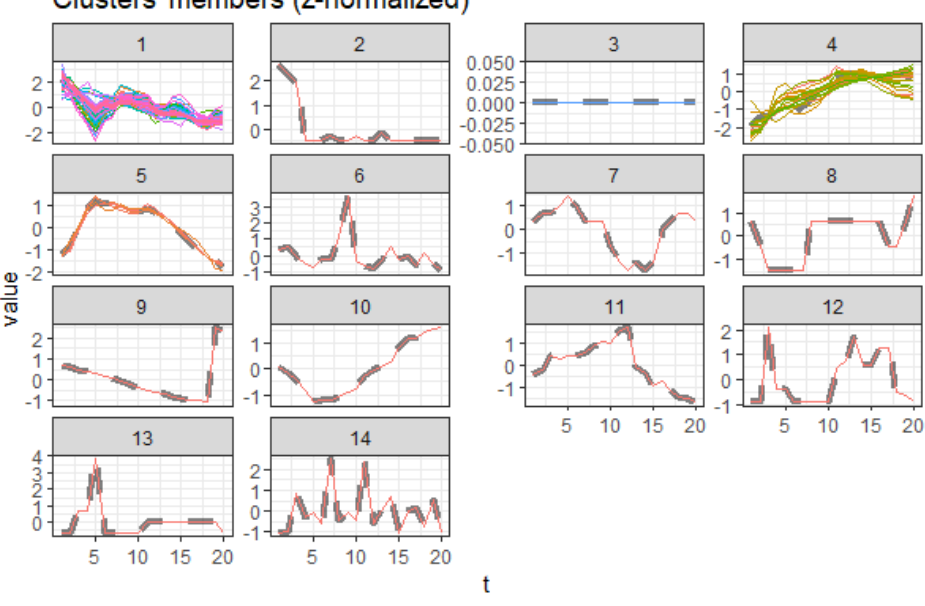
Figure 7. Cluster extraction for females aged 20 to 60.